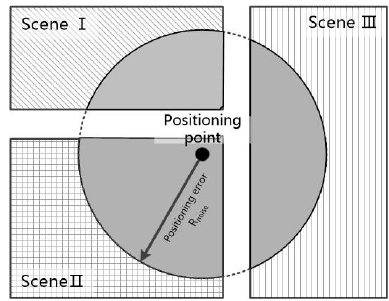
Figure 5. The overlap of scene and error circle.